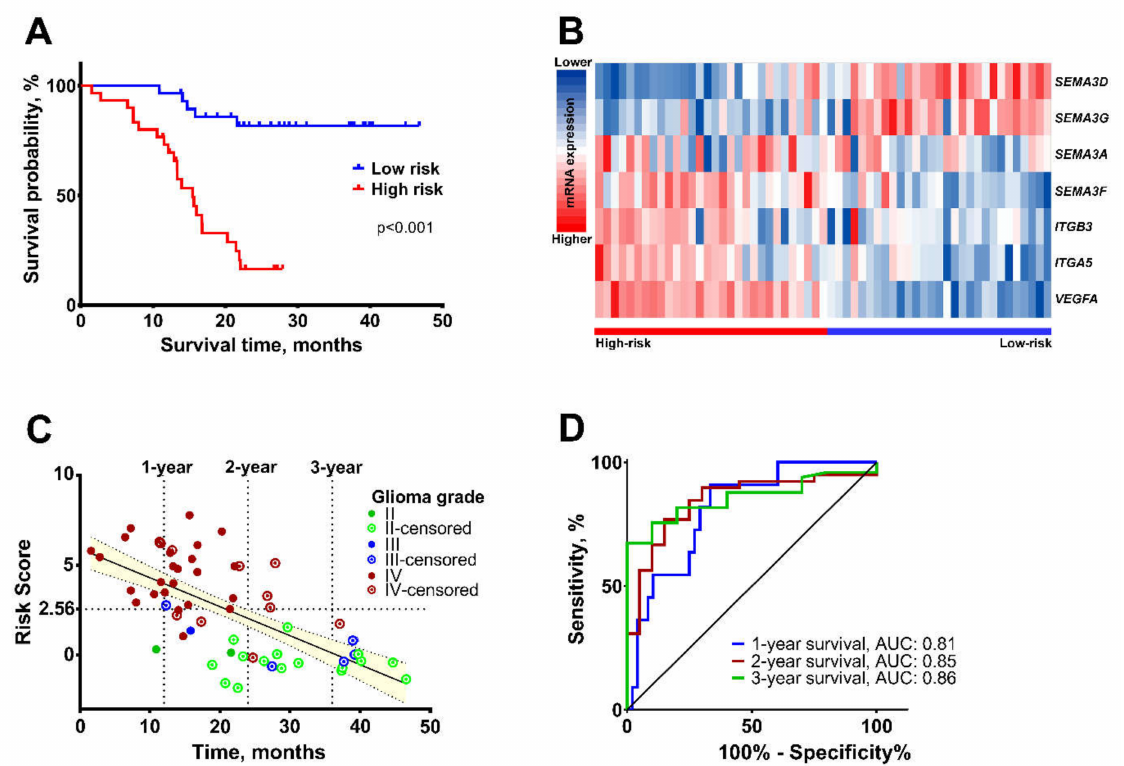
Figure 4. Characteristics of a multi-biomarker in training cohort. ( A ) Kaplan-Meier analysis in high-risk and low-risk patient groups, arranged by seven-gene risk score median; log-rank test, p < 0.05. ( B ) The heatmap of mRNA expression distribution of seven genes in high-risk and low-risk patient groups. ( C ) Distribution of patient status with the diagnosis of di ff erent malignancy grade glioma tumor, according to survival time and seven-gene risk score. The median risk score value 2.56, r = − 0.66, p < 0.001. The yellow-shaded area represents 95% confidence interval. ( D ) ROC curves of 1-, 2-, and 3-year patient survival, according to the seven-gene